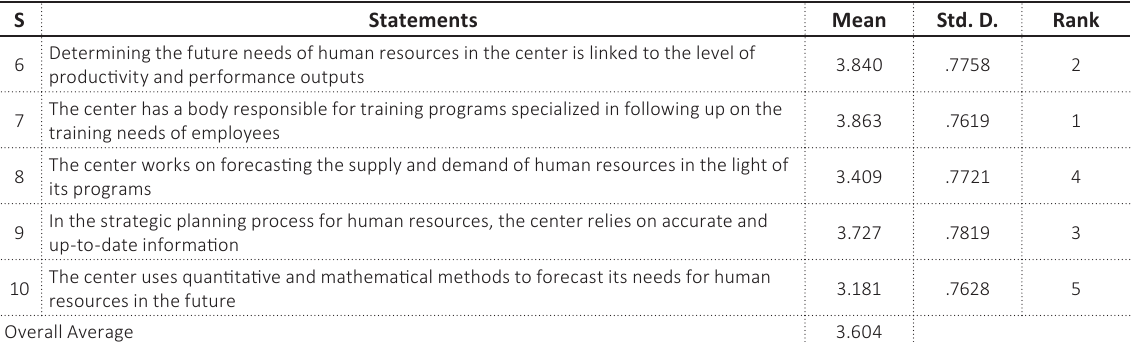
Table 2. Means and standard deviations of the forecasting the future needs of human resources